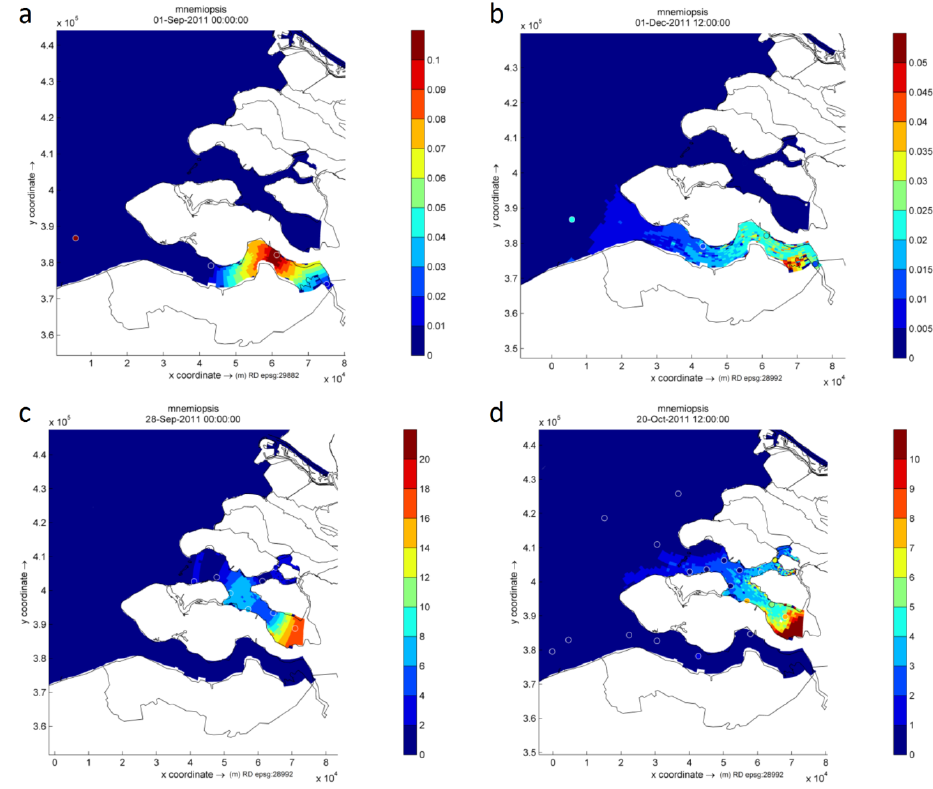
Figure 4. Observed density M. leidyi (individualsm − 3 ), realistic runs for 2011. ( a ) and ( c ) initial density based on field observations (circles) for western and eastern Scheldt, respectively. ( b ) and ( d ) final simulated density and field observations (circles) for western and eastern Scheldt, respectively. Table 3. Percentage of particles from the western Scheldt estuary per area after 30 days. Eastern Western Eastern Western Zeebrugge rest Scheldt Scheldt Scheldt mouth Scheldt mouth area North